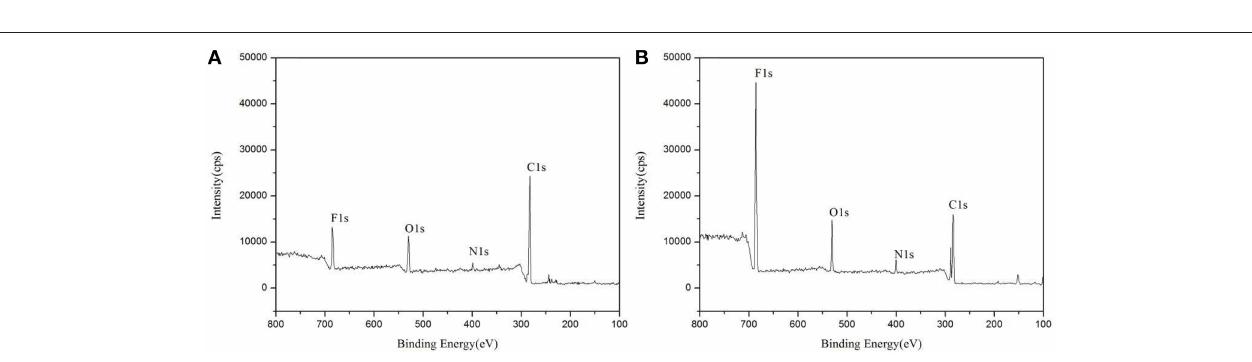
FIGURE 4 | X-ray photoelectron spectrum of PVDF/IL (A) and PVDF/IL/CNTs (B) .